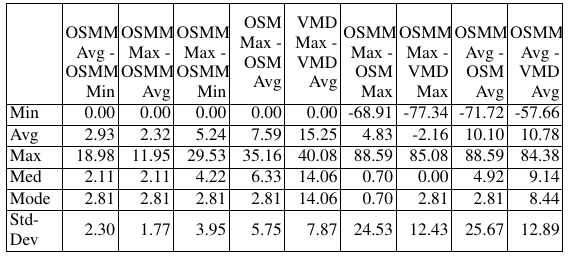
Table 3: Variation in Elevation Values Comparing Datasets - En- tire Test